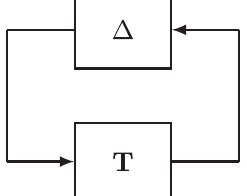
FIG. 3. System interconnection for the application of small gain